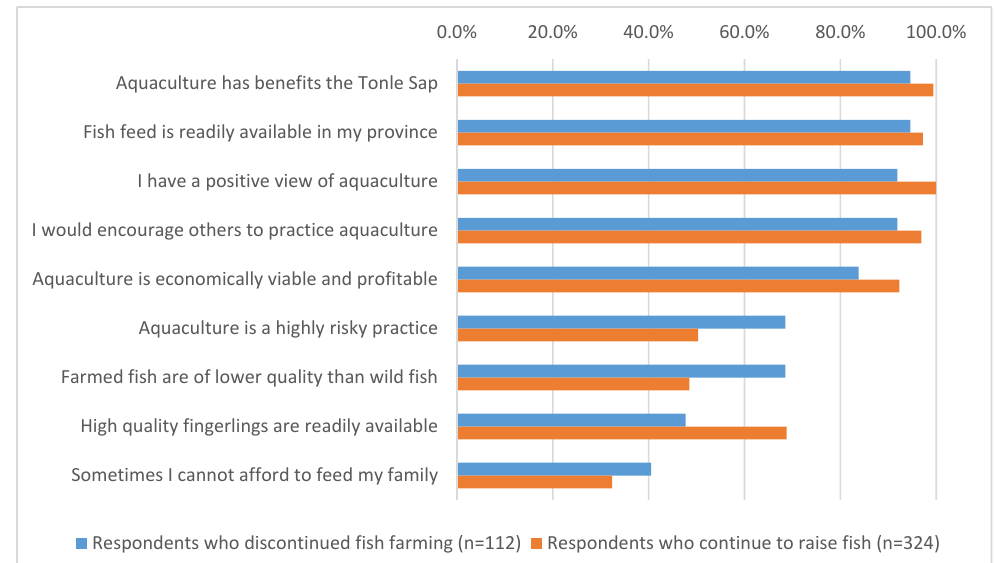
Figure 3. Reasons for discontinuing the practice of small-scale aquaculture ( n = 112).